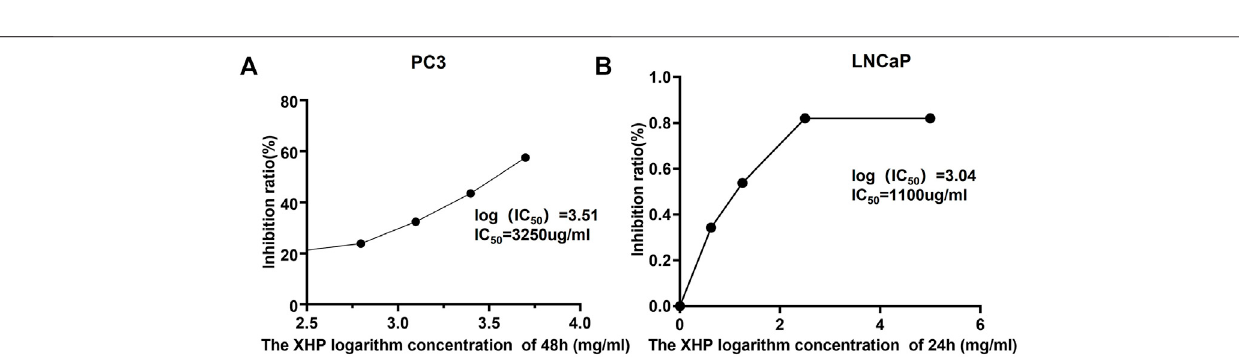
Frontiers in Pharmacology |